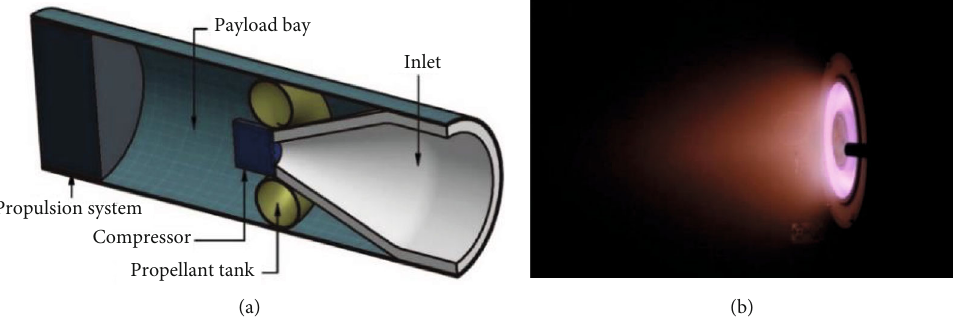
Figure 21: RF-ABEP: (a) cross-section of a notional atmosphere-breathing spacecraft; (b) single-stage Helicon Hall Thruster (HHT) operation with nitrogen propellants [51].